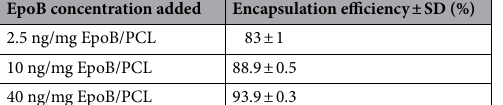
EpoB concentration